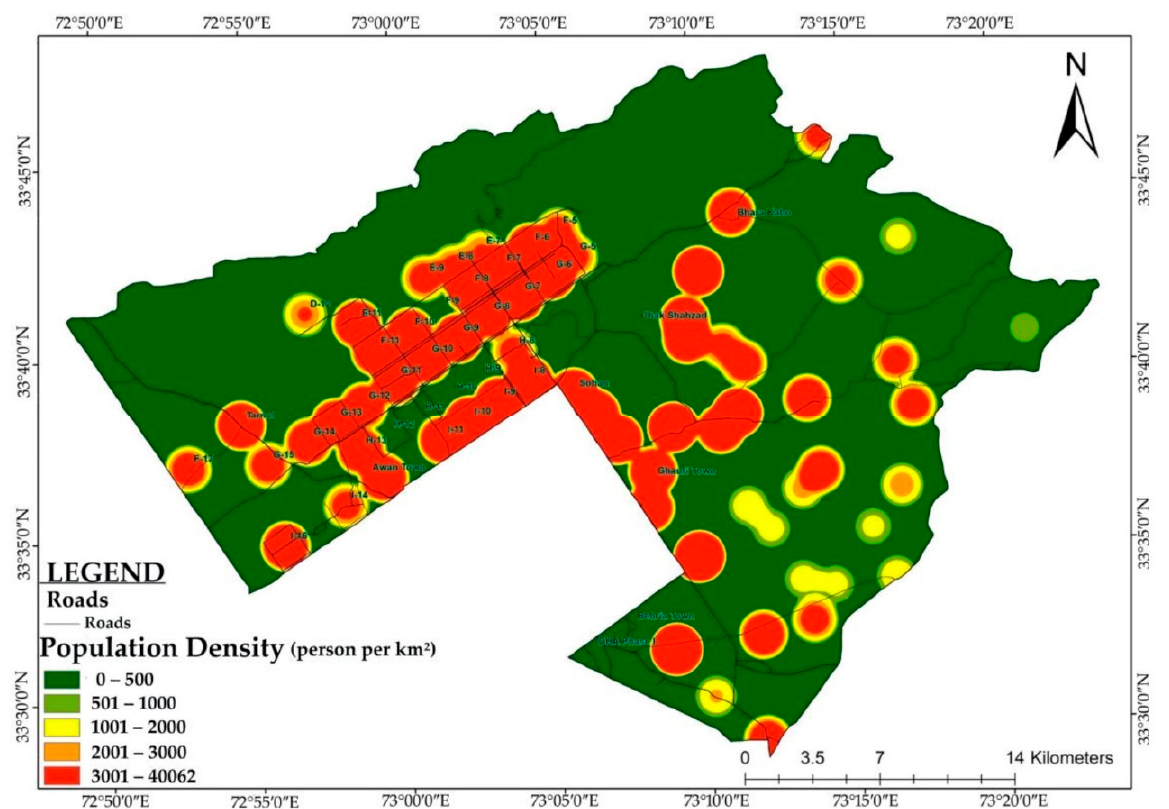
Figure 3. Population Density.